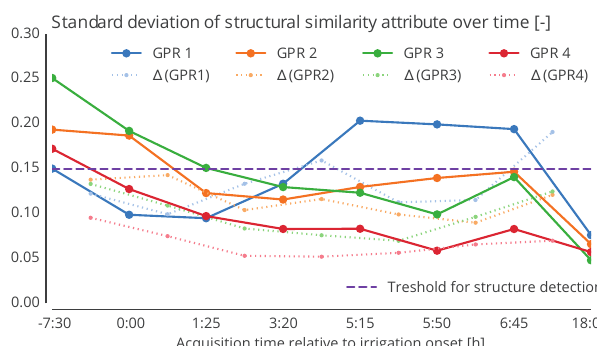
Figure E1. Standard deviation of the structural similarity attribute at the different GPR transects in the hillslope experiment over time (solid lines) and standard deviation of the differences of two succes- sive attribute distributions (dotted lines). The used threshold for the detection of flow-relevant structures is marked as the dashed purple